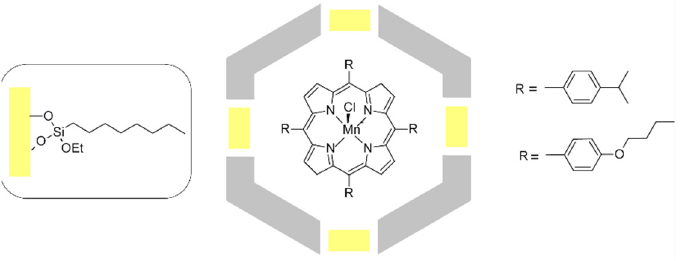
Figure 5. Schematic incorporation of two manganese porphyrins in SBA-15 modified with octyltri- ethoxysilane [69].